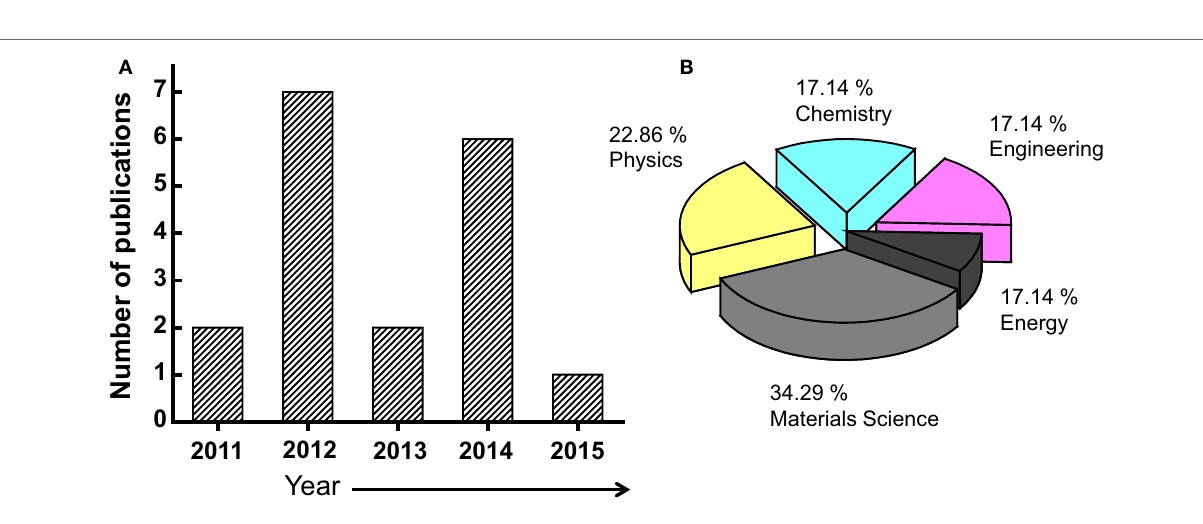
FiGURe 3 | (A) Number of the review publications/year on the graphene materials. (B) Distribution of the review publications per subject area.